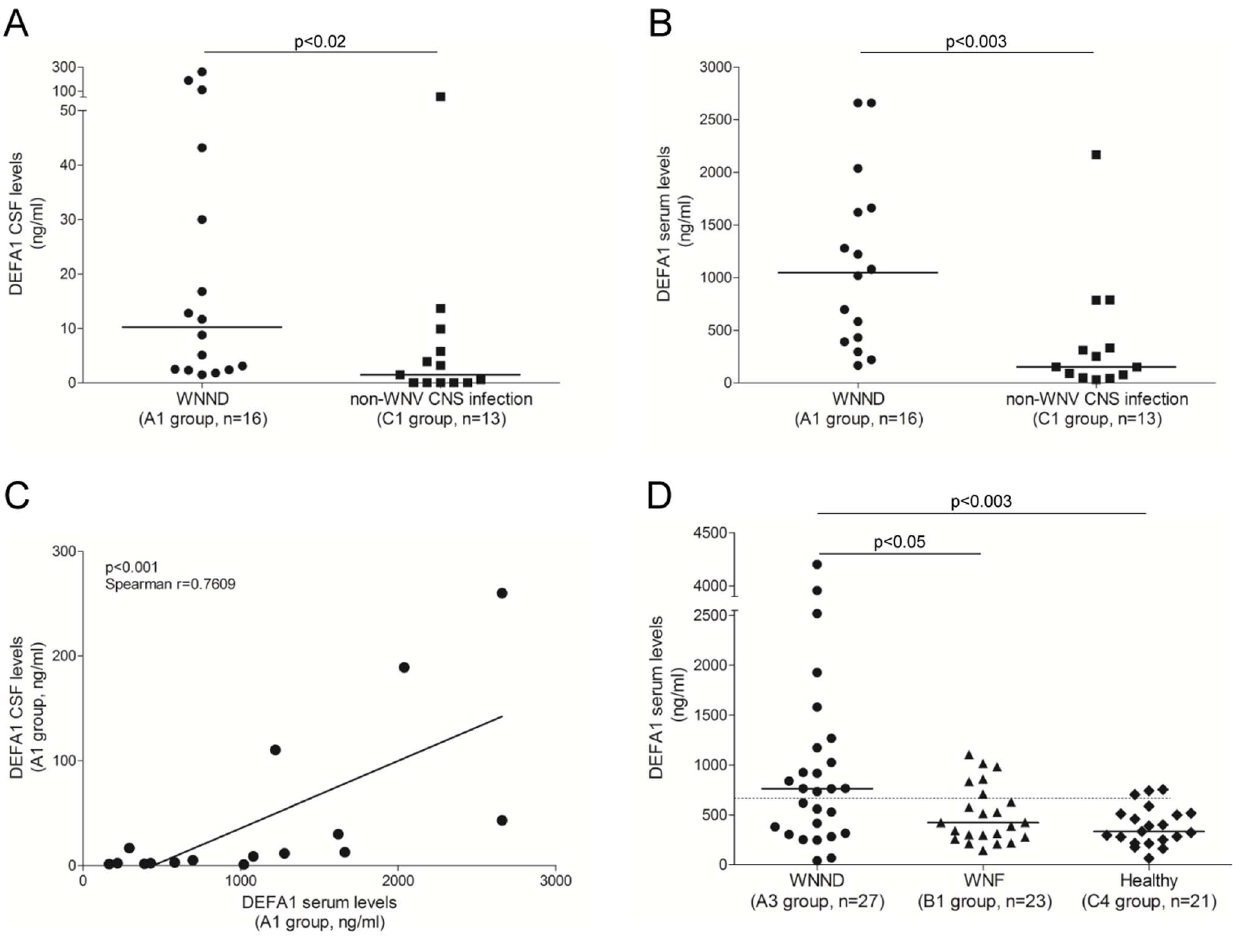
Figure 2. DEFA1 expression levels from patients with WNND, WNF and control groups. CSF (A) and serum (B) levels of DEFA1 measured by ELISA between WNND patients (n=16, A1 group) and subjects with non-WNV CNS infection (n=13, C1 group). Each dot shows the mean DEFA1 concentration detected in serum from a single individual. Horizontal bars show medians. Data were compared using the non parametric Mann- Whitney U test. (C) Correlation of DEFA1 levels between paired CSF and serum from WNND patients (n=16, group A1). The data were analyzed using Spearman’s rank correlation test with the best-fit line shown (black line). (D) Serum levels of DEFA1 measured by ELISA between WNND (n=27, A3 group), WNF (n=23, B1 group) patients and healthy individuals (n=21, C4 group). Each dot shows the mean DEFA1 concentration detected in serum from a single individual. Horizontal bars show medians. Data were compared using the non parametric Mann-Whitney U test. The dotted line corresponds to the threshold value defined by ROC curve. WNND, West Nile neuroinvasive disease; WNF, West Nile fever; CNS, central nervous system; CSF, cerebrospinal fluid; DEFA1, defensin-1 alpha.